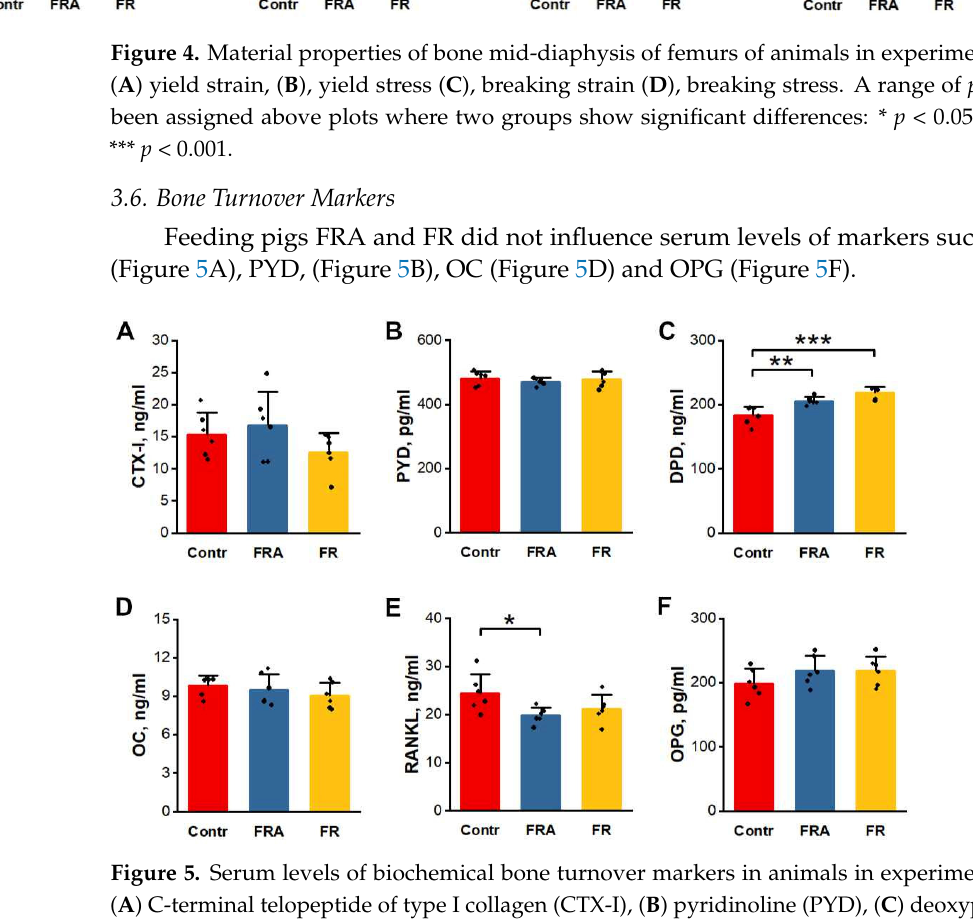
Figure 4. Material properties of bone mid-diaphysis of femurs of animals in experimental groups. ( A ) yield strain, ( B ), yield stress ( C ), breaking strain ( D ), breaking stress. A range of p -values has been assigned above plots where two groups show significant differences: * p < 0.05, ** p < 0.01, *** p < 0.001.